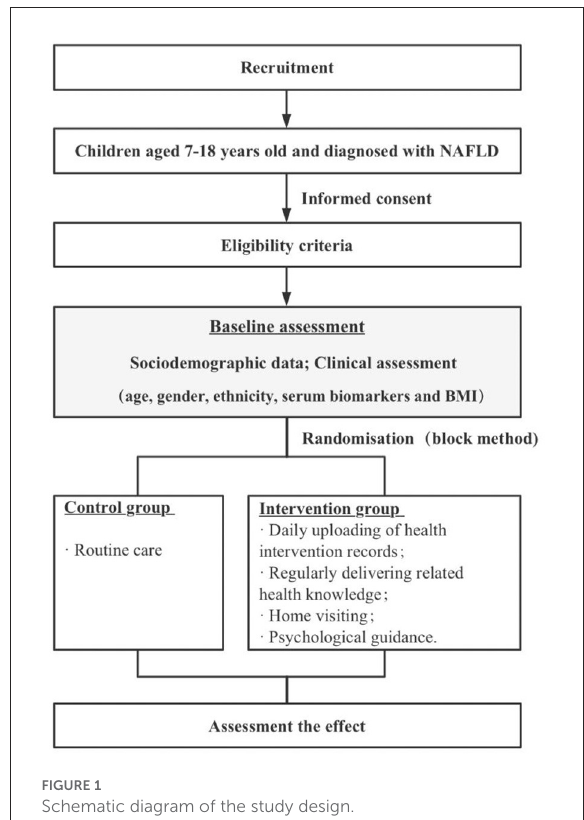
FIGURE1 Schematic diagram of the study